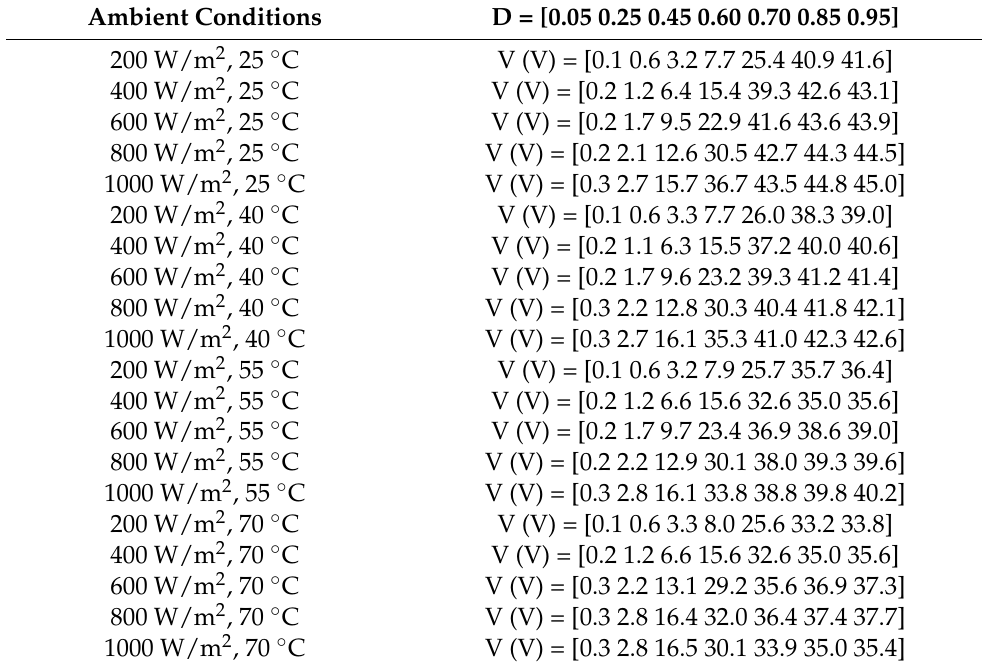
Table A1. Duty ratio versus voltage lookup-table at varying ambient